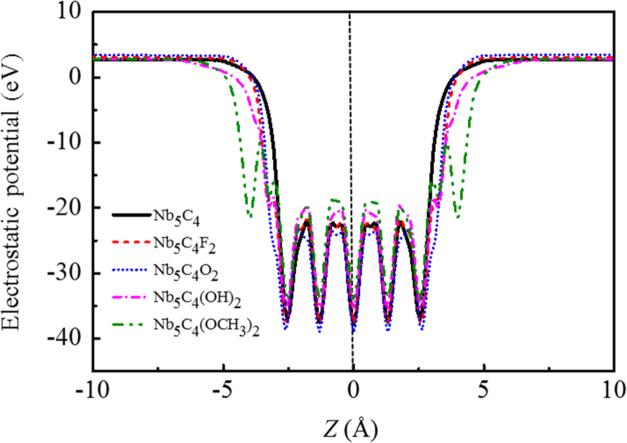
Planar averaged electrostatic potentials along the Z direction of Nb5C4 and Nb5C4Z2 (Z = F, O, OH, OCH3). The peaks in green circles are enlarged to be more clearly.